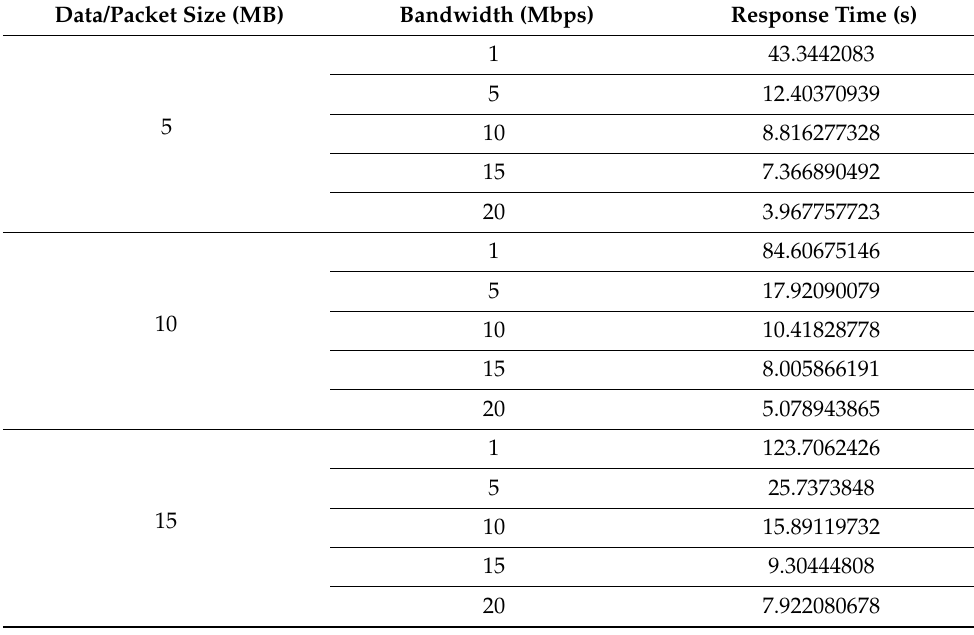
Table 3. ULSM to HMS (Intranet).